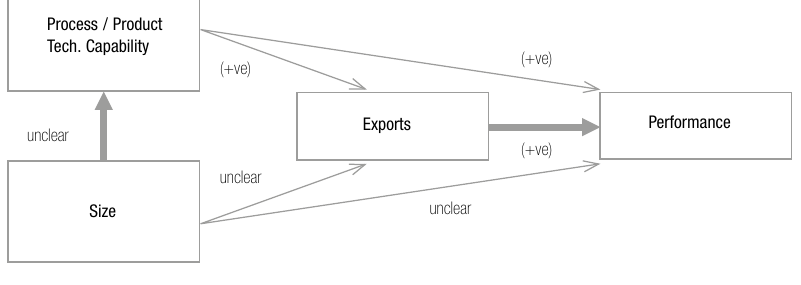
Fig. 1. Framework of